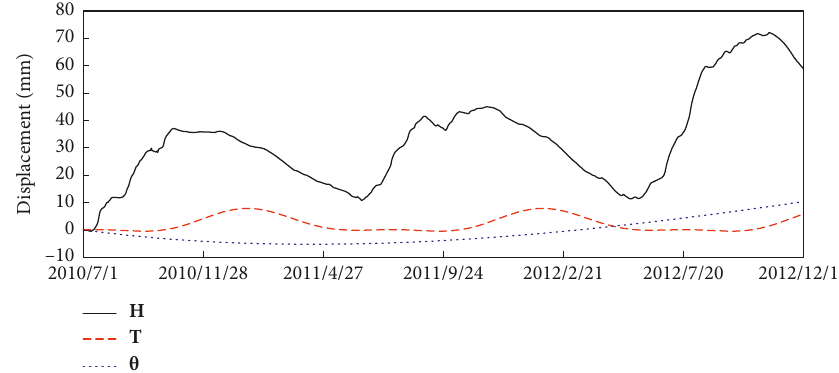
Figure 8: Independent component hydrographs of the KPLS model for radial